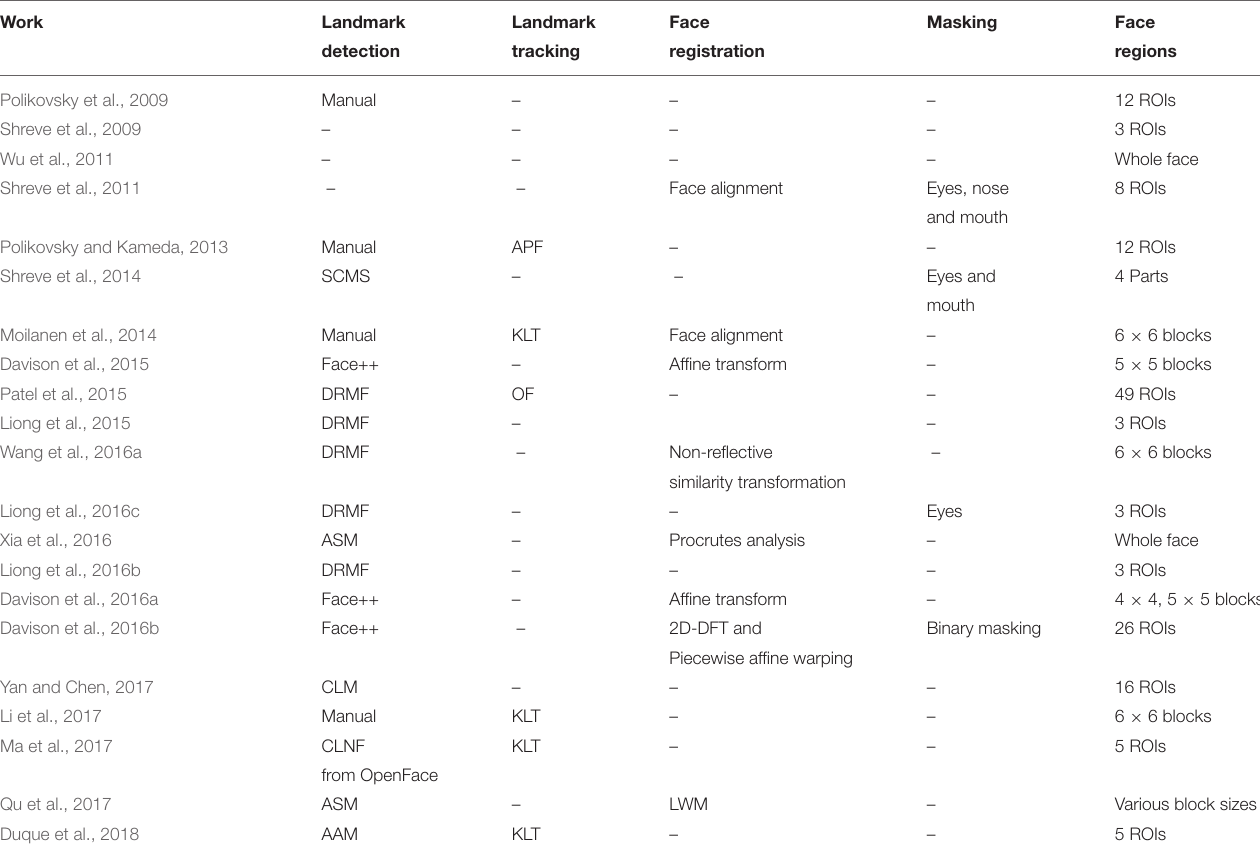
TABLE 2 | A survey of pre-processing techniques applied in facial micro-expression